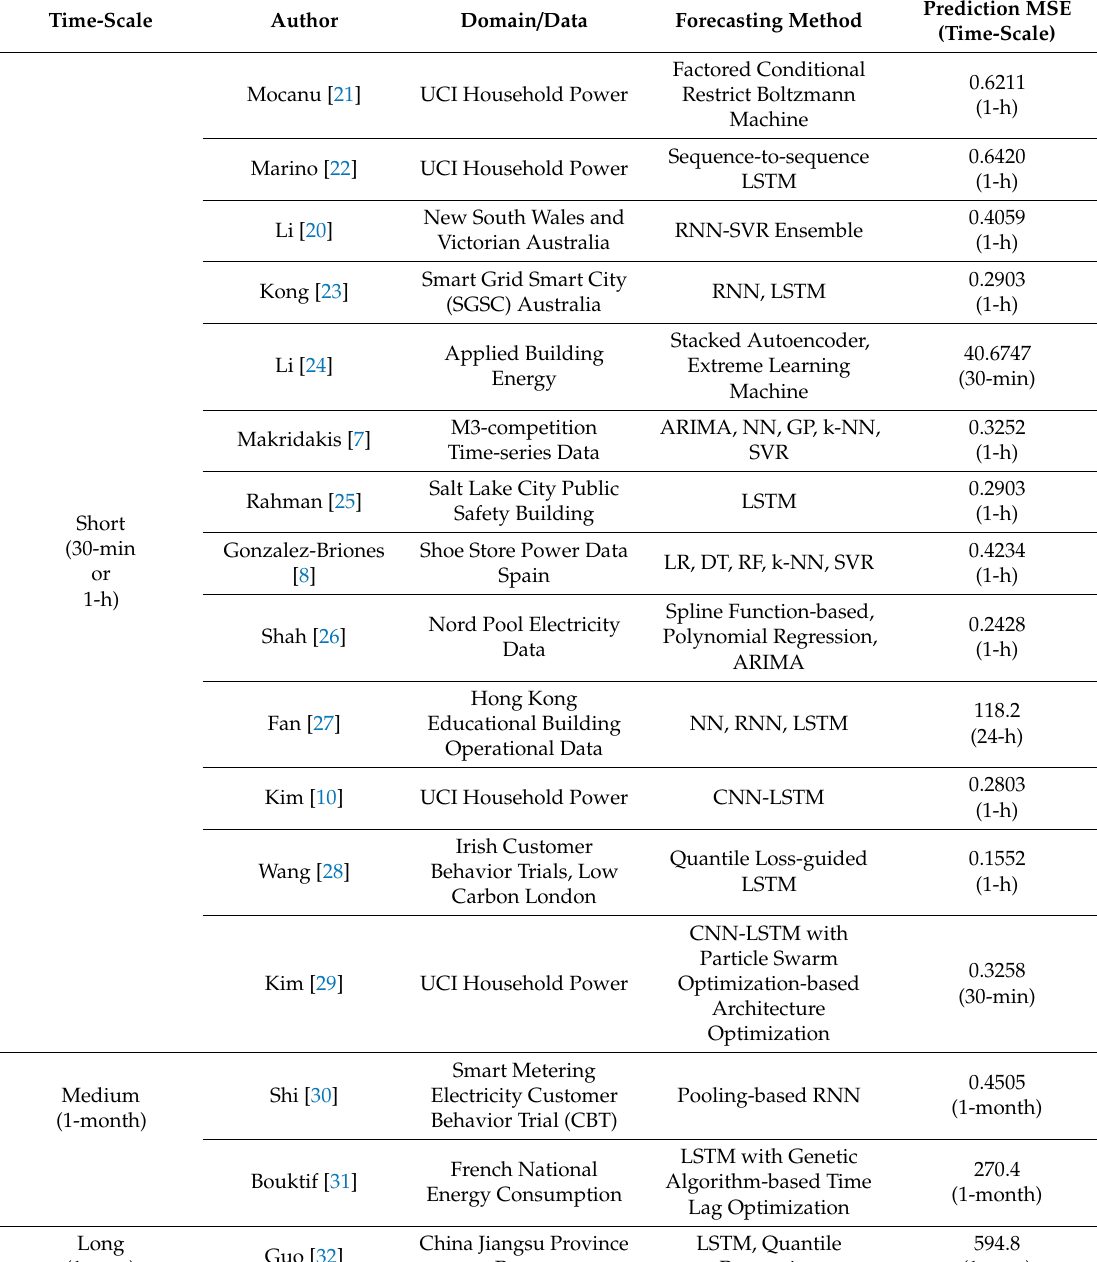
Table 1. Related works on the residential energy consumption prediction based on deep